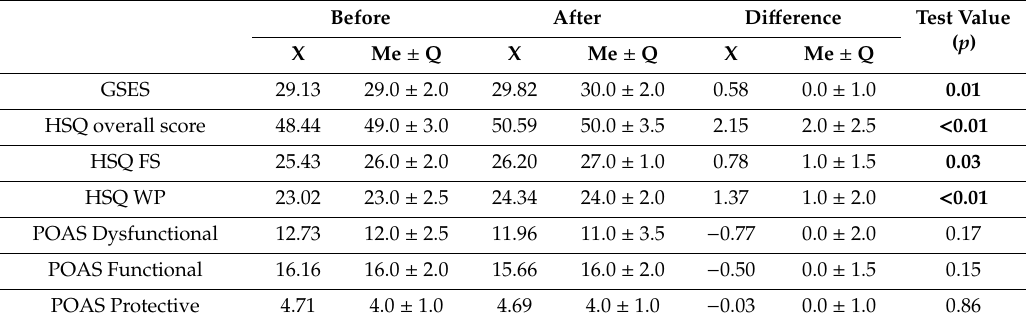
Before After Di ff erence Test Value